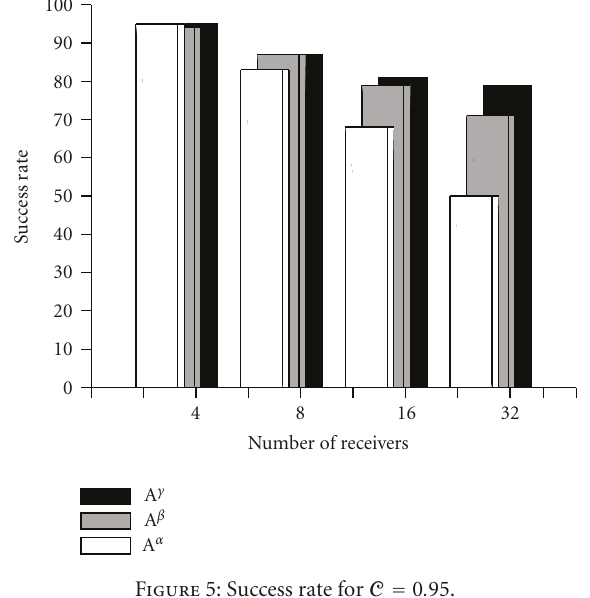
Figure 5: Success rate for C = 0 . 95.